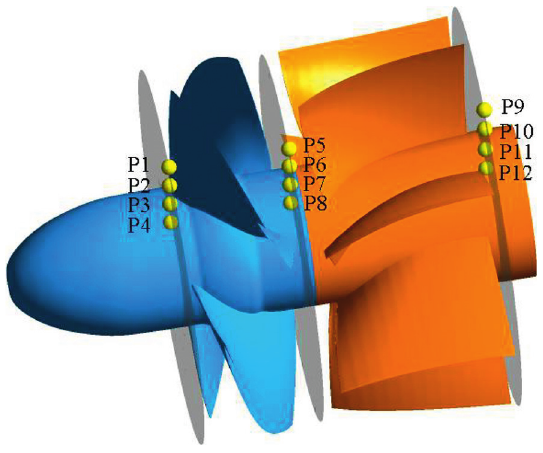
Figure 15: Distribution of monitoring